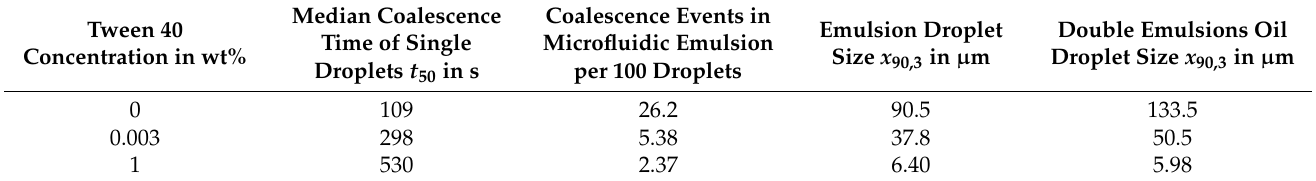
Table A2. Comparison of the effect of the three different measurement methods on the example of different Tween 40 concentrations the with addition of PGPR. For the microfluidic experiment, the values are from after 90 days and for the emulsification experiments, from after 14 days.